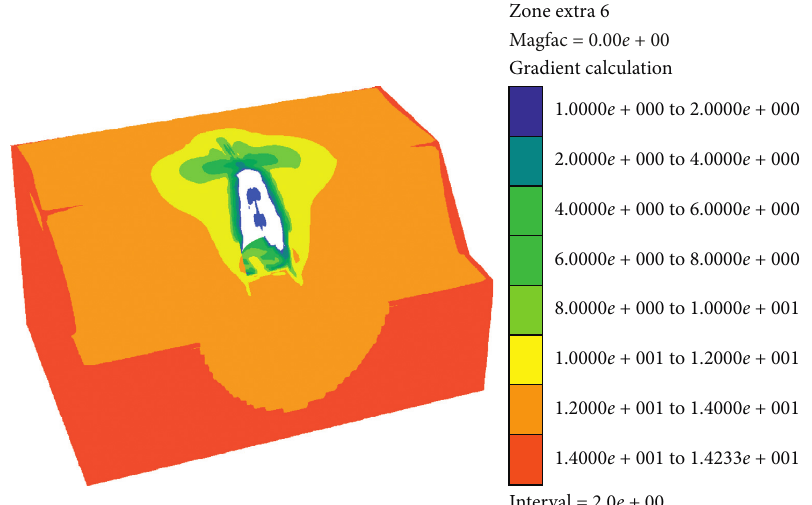
Figure 30: Distribution zone of generalization sensitivity of the overlaying slope.